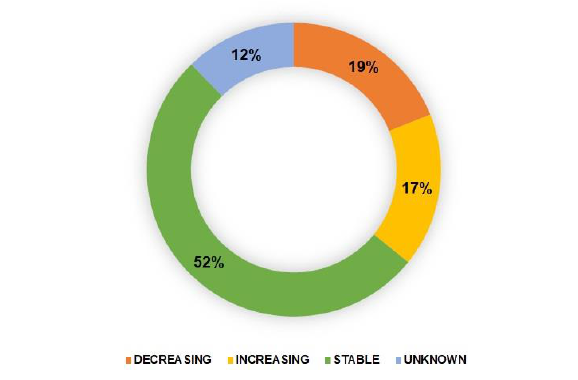
Figure 5. Relative distribution of bird species recorded in Durgapur Government